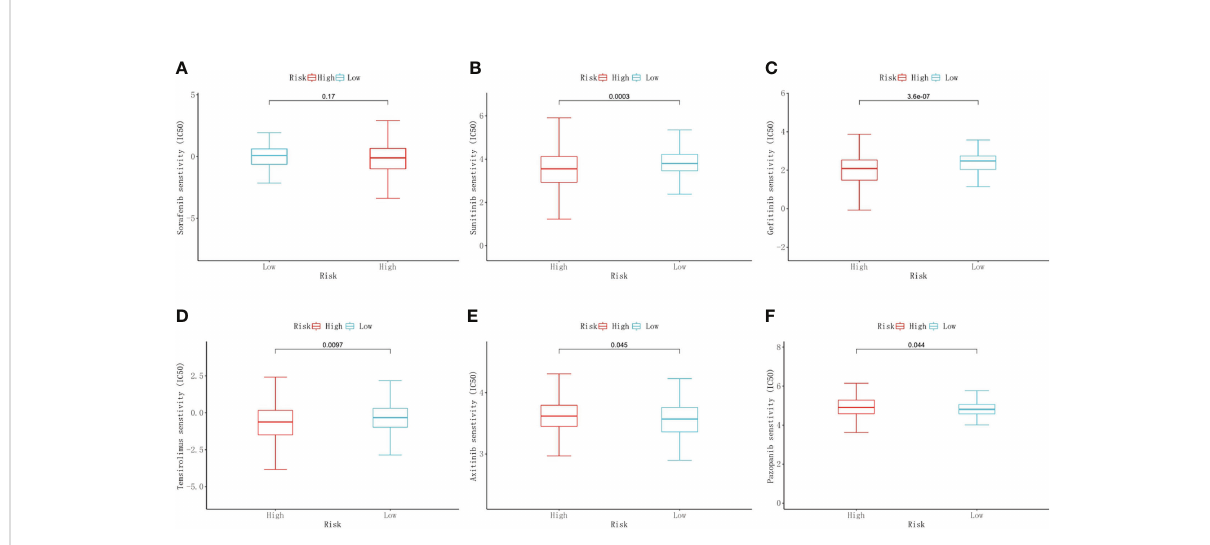
FIGURE 9 Predictive results of chemotherapeutic responses. The differences in the chemotherapeutic response to common chemotherapeutic drugs between the high- and low-risk groups (A – F)